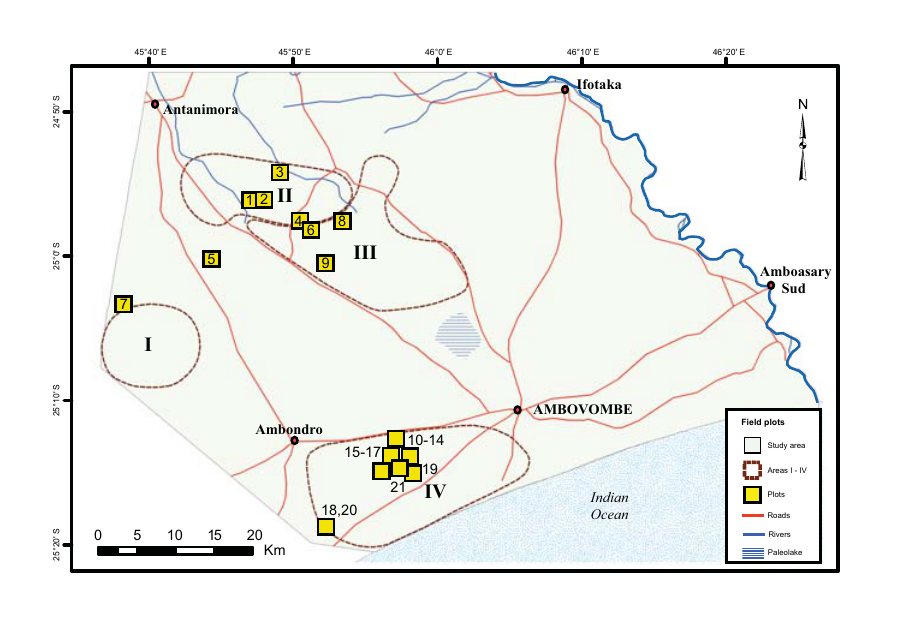
Figure 1. The Androy region is situated in the southernmost part of Madagascar between Lat 24 u 13 9 and 25 u 24 9 S and Long 45 u 20 9 and 46 u 26 9 E. Four areas (I–IV) were selected for detailed field investigations. Yellow squares with numbers indicate plots used in ground truthing.